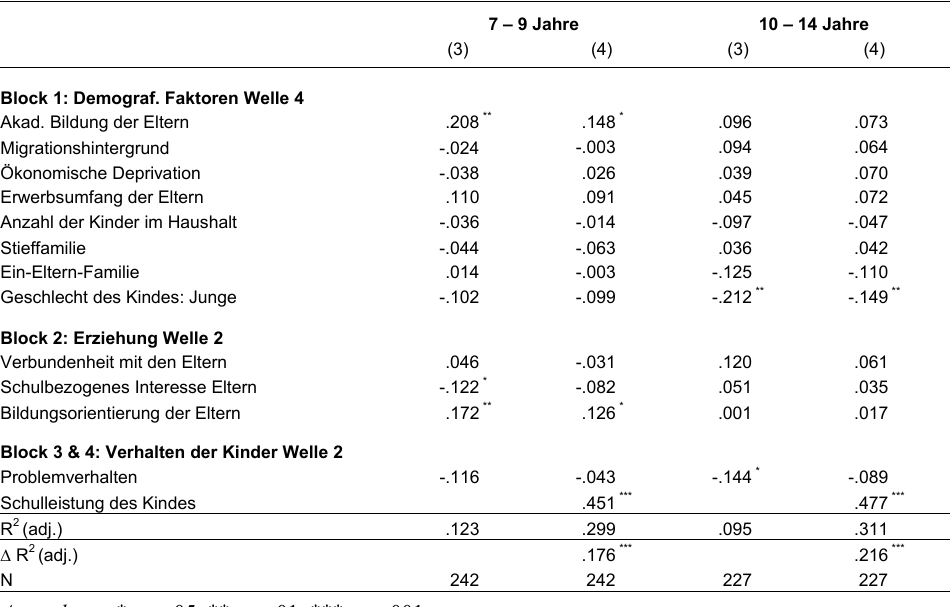
Tabelle 2 : Effekte auf Schulleistung Welle 4 in Abhängigkeit vom Alter der